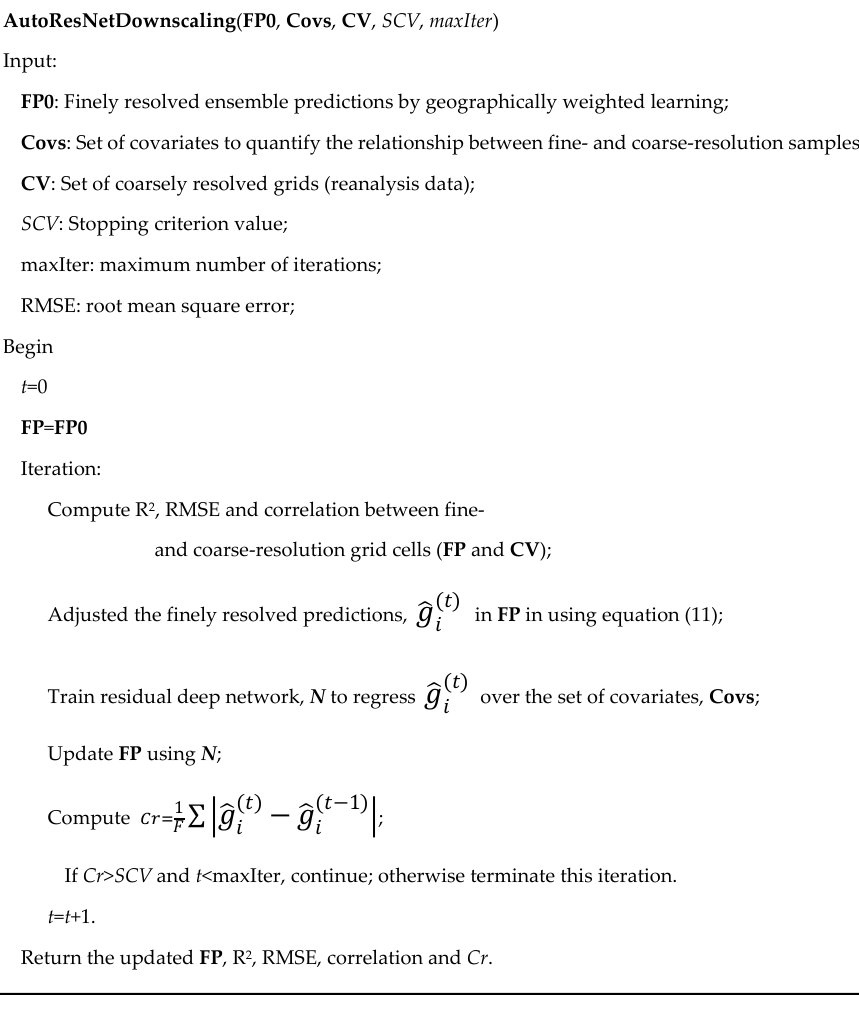
Figure 5. Downscaling algorithm by autoencoder-based deep residual network.